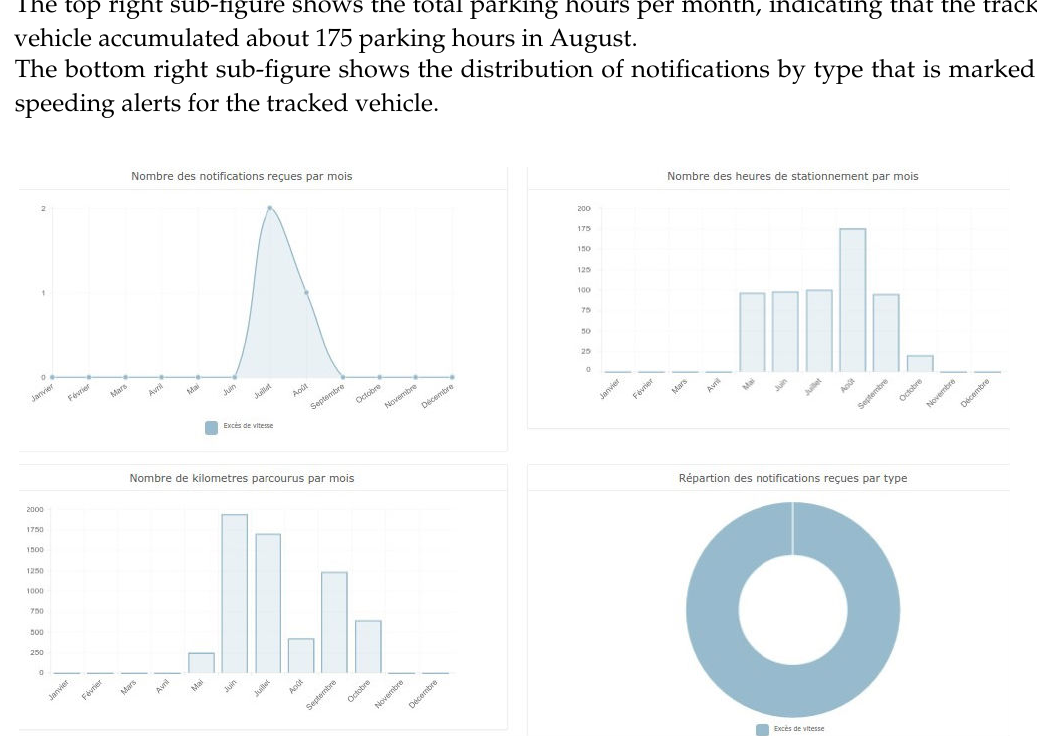
Figure 13. Screenshot of the server console showing the capabilities to draw different types of